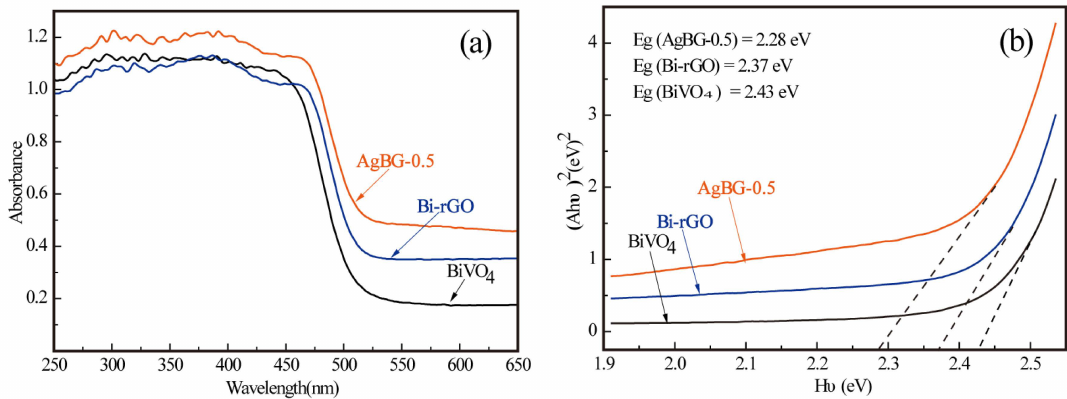
Figure 6. ( a ) UV-vis DRS spectra; and ( b ) the relationship between (Ah υ ) 2 and the photon energy (h υ ) of the as-synthesized pure BiVO 4 , Bi-rGO, and